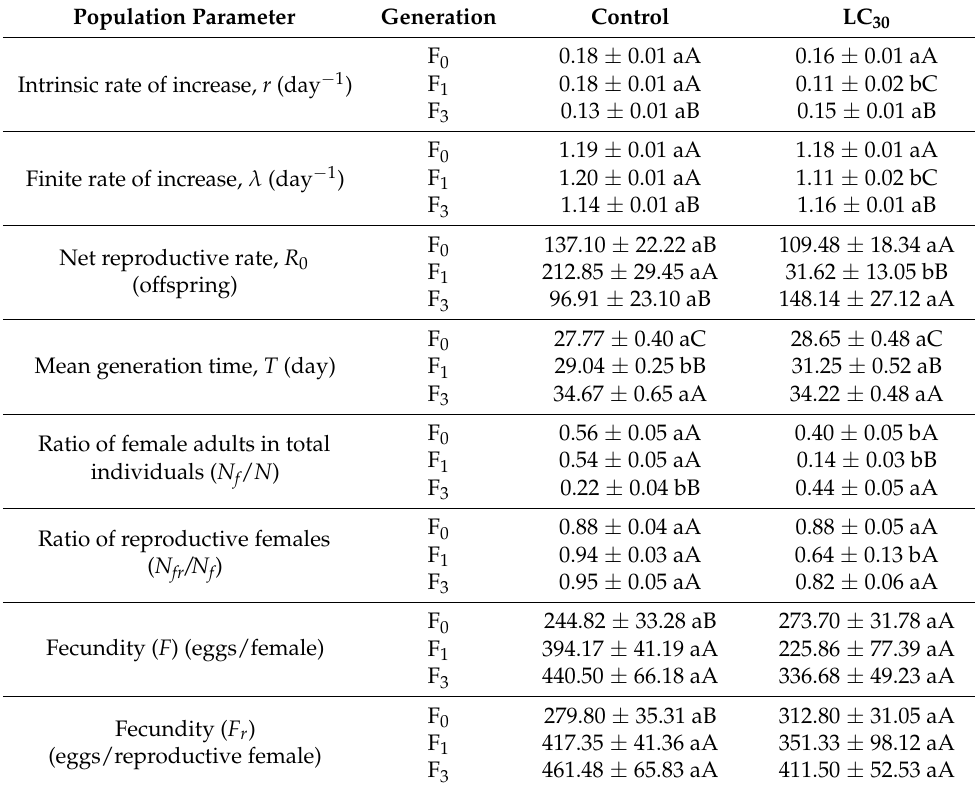
Table 2. Sublethaleffectsofchlorfenapyronthepopulationparametersof P . marginatus indifferentgenerations.